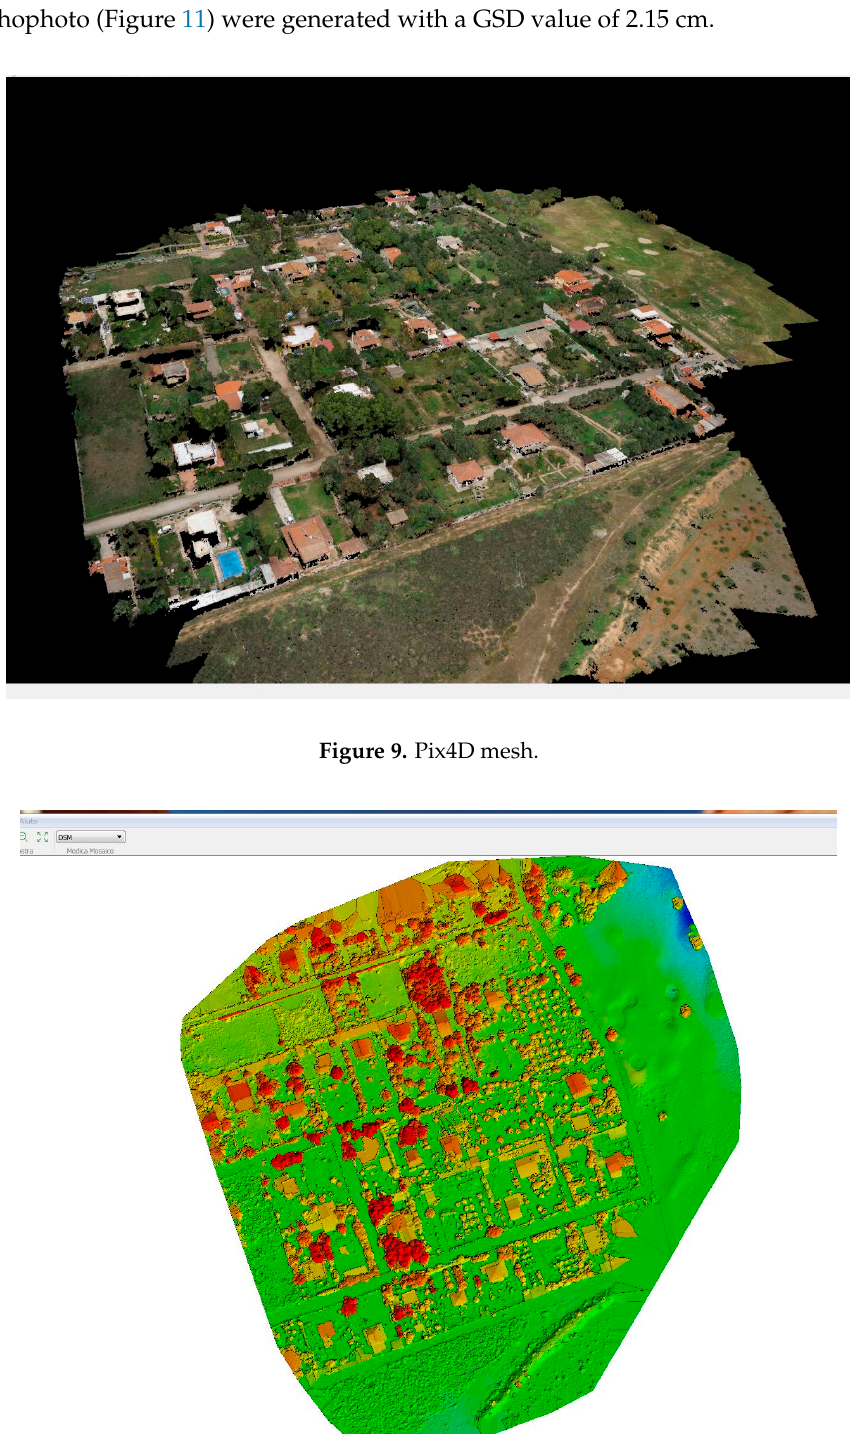
Figure 10. Pix4D raster DSM.